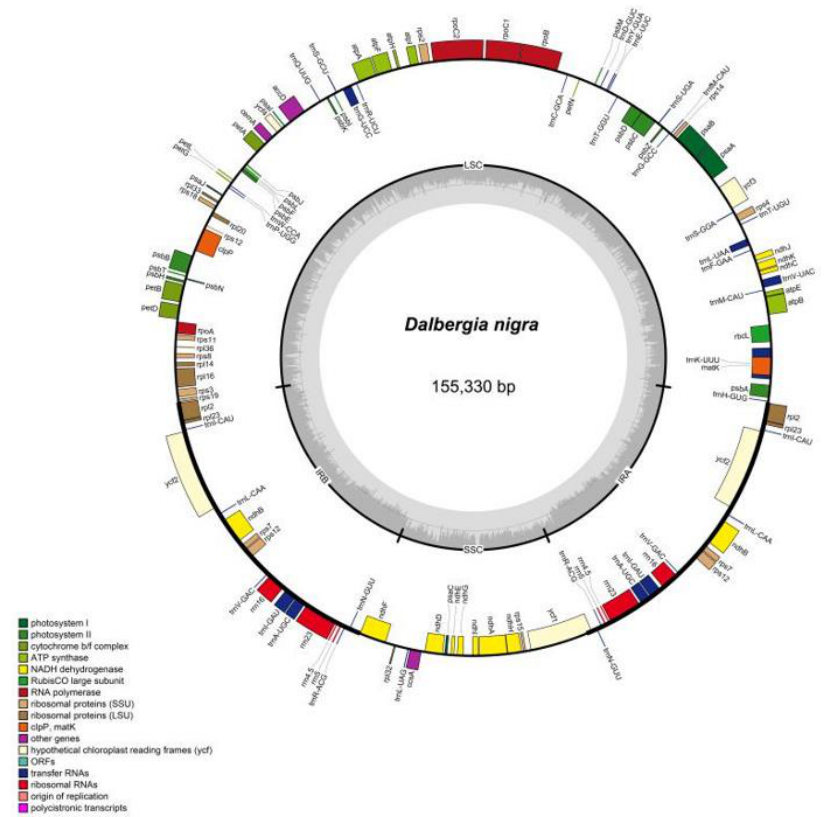
Figure 1. Gene map of the D. nigra chloroplast genome. Genes shown inside the circle are transcribed clockwise, and those outside are transcribed counterclockwise. The darker gray in the inner circle corresponds to the GC content. The IRA and IRB (two inverted repeating regions); LSC (long single-copy region); and SSC (short single-copy region) are indicated outside of the GC content. Table 1. Summary of the complete chloroplast genomes sequenced for this study.